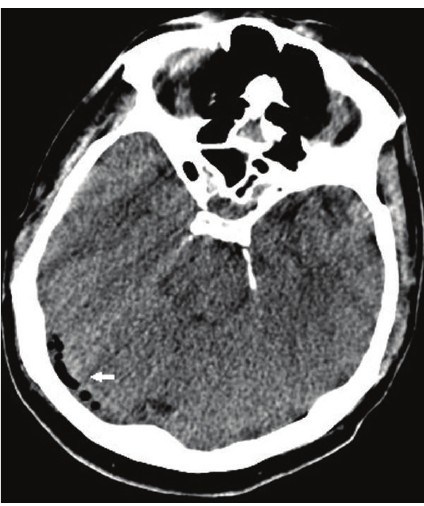
Figure 2: Axial T2-weighted MRI revealed signal void loss on the right sigmoid and transverse sinuses.